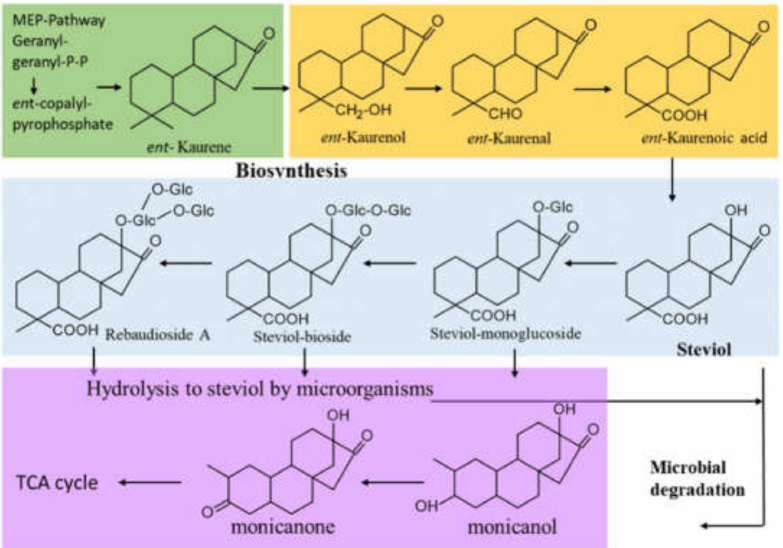
Figure 8. Biosynthesis and degradation of stevioside (simplified). Chloroplasts: green box. ER-located oxidases: yellow box. Cytosol: blue box. Degradation: purple